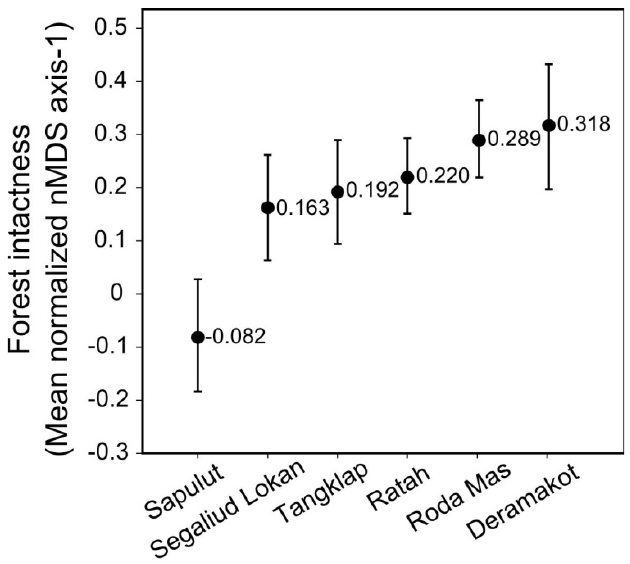
Figure 5. Mean values of normalized nMDS axis-1 scores in all FMUs.